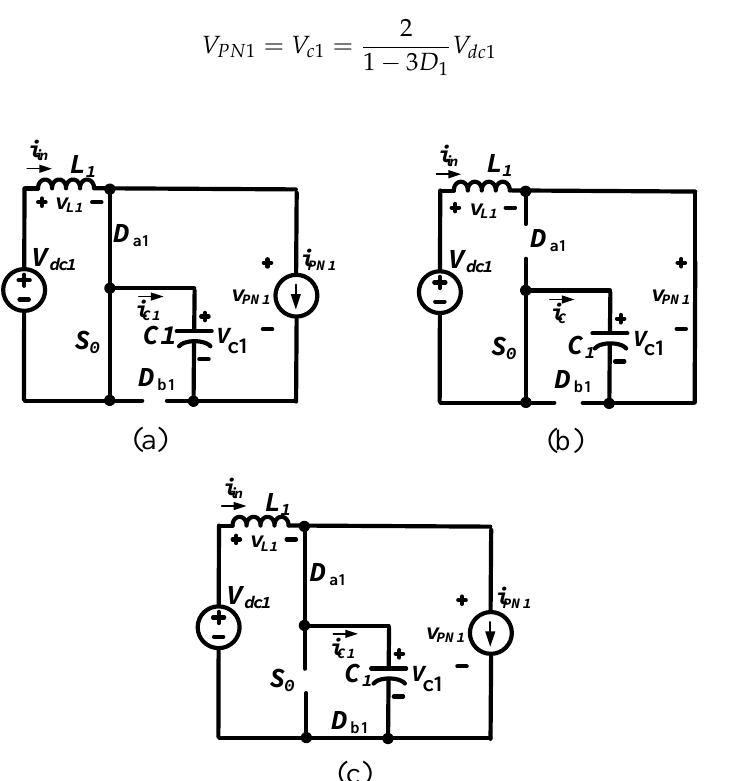
Figure 4. Operating states of qSBI module 1: ( a ) non-shoot through (NST) 1, ( b ) shoot-through (ST), and ( c ) NST 2 states.